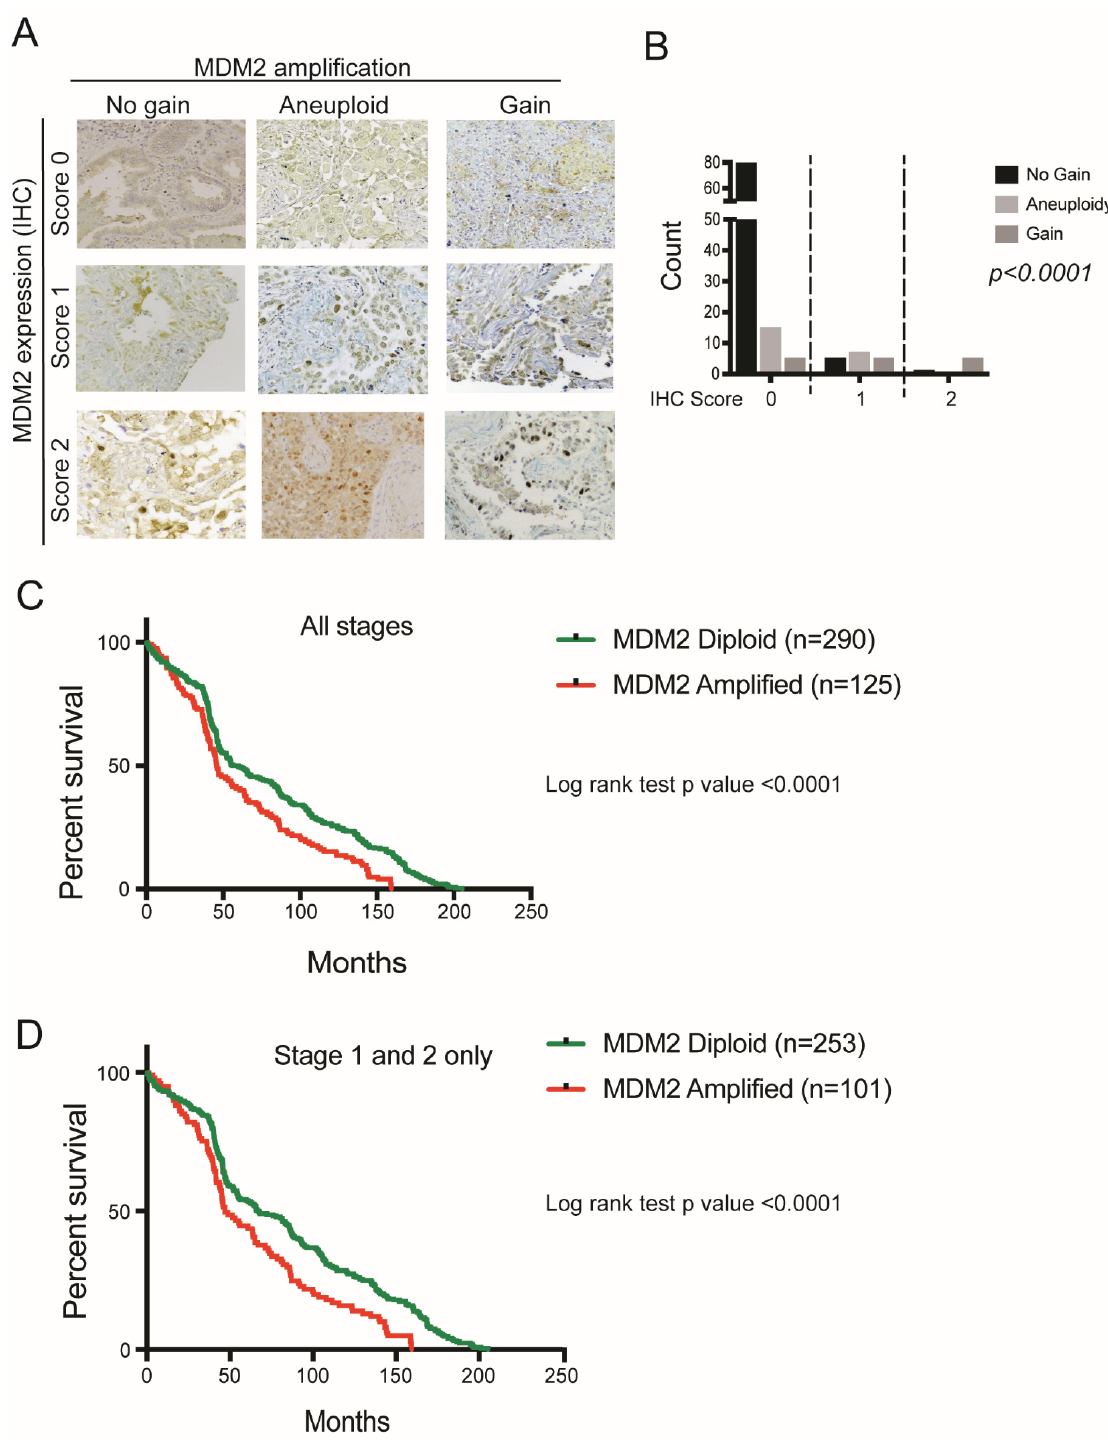
Figure 2. MDM2 copy number amplification is correlated with protein overexpression and worse survival in LUAD patients. ( A ) Representative images for MDM2 immunohistochemistry on LUAD tissue microarray n = 124, for patients with MDM2 IHC score 0, 1 or 2 having no gain, aneuploid and gain as identified by FISH/CISH. ( B ) Chi-square plot showing correlation between MDM2 copy number and IHC protein expression in LUAD patients, n = 124, p < 0.0001. ( C ) Percent overall survival for MDM2 amplified (n = 125) and MDM2 diploid (n = 290) LUAD patients for all stages, LRT p < 0.0001. ( D ) Percent overall survival for MDM2 amplified (n = 101) and MDM2 diploid (n = 253) LUAD patients for Stage 1 and 2 only, LRT p < 0.0001. The magnification of the figure is 10 ×